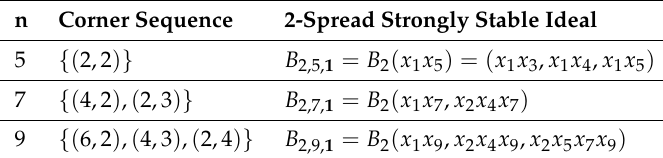
Table 1. Corner sequences for n =